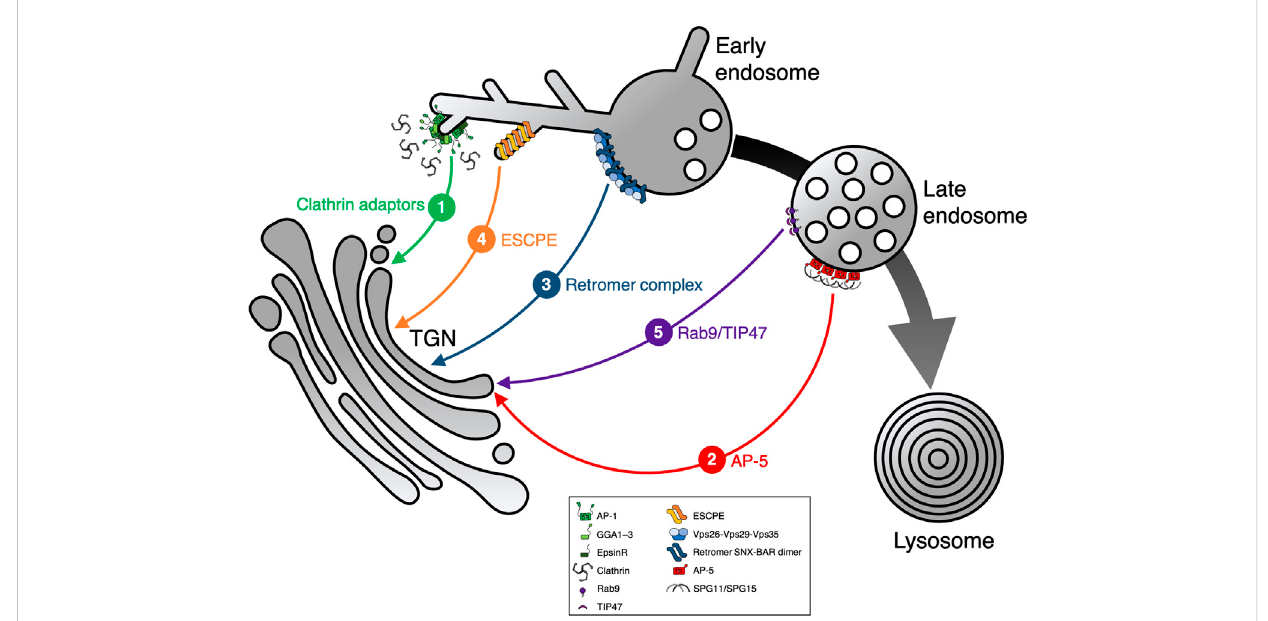
FIGURE 2 Sortingmachineriesinvolvedinendosome-to-TGNtransport.Followingcargointernalization via endocytosis,severalpathwaysexistthatsortcargo protein from endosomes to the TGN. Cargo protein sorting can either occur from early or late endosomes, mediated by different sorting machineries: 1) clathrin adaptors, 2) AP-5, 3) retromer complex, 4) ESCPE (including ESCPE-1), and 5) Rab9/TIP47. All these pathways operate in parallel, though the extent of cooperation remains unknown. Clathrin adaptors include AP-1, GGA1 – 3, and epsinR. The large black/gray arrow highlights endosome maturation, thin colored lines represent individual transport pathways mediated by machinery as indicated (1 –